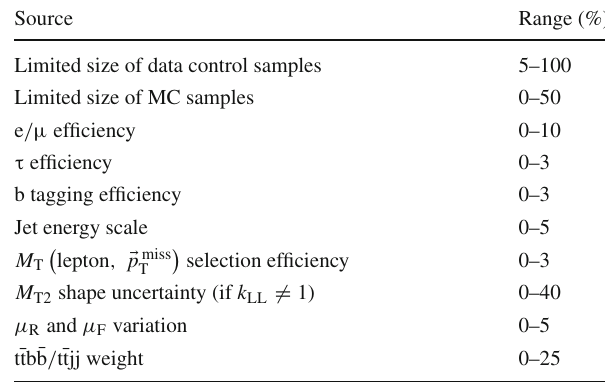
Table 2 Summary of systematic uncertainties in the lost-lepton back- ground prediction, together with their typical size ranges across the search